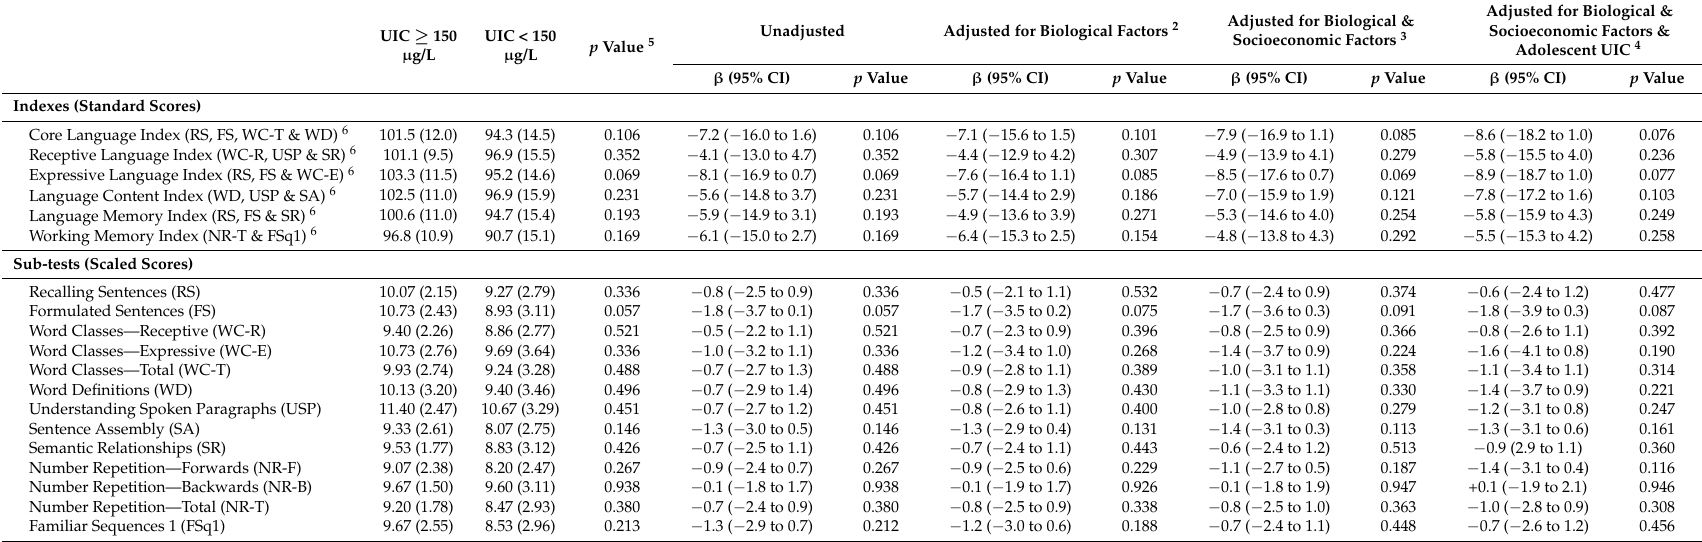
1 Data for differences in outcomes are means (SD) for continuous variables and percentages ( n / N %) for categorical variables. 2 Model adjusted for gestational age at the time of maternal UI collection, maternal age at birth of child, gestational length at time of birth, birth weight and sex. 3 Model adjusted for all of the above and for maternal education. 4 Model adjusted for all of the above and for adolescent UIC. 5 p values for differences in outcomes were calculated using t tests for continuous variables and X 2 tests for categorical variables. 6 RS—Recalling Sentences; FS—Formulated Sentences; WC-T—Word Classes-Total; WC-R—Word Classes-Receptive; USP—Understanding Spoken Paragraphs; SR—Semantic Relationships;